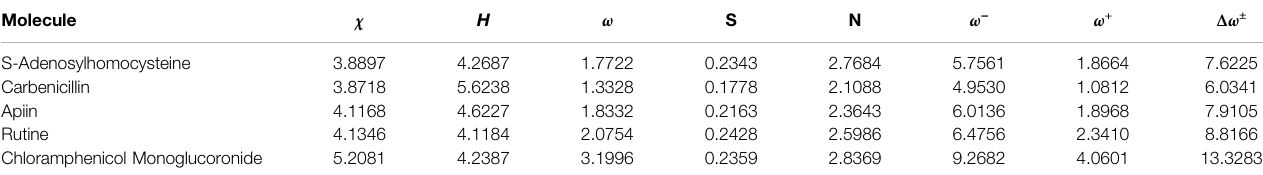
TABLE 4| GlobalReactivity DescriptorsoftheFive Studied Ligands: Electronegativity( χ ),Hardness ( η ),Electrophilicity ( ω ) (allineV), Softness (S)(in eV − 1 ),Nucleophilicity (N), Electrodonating Power ( ω − ), Electroaccepting Power ( ω + ) and Net Electrophilicity ( Δ ω ± ) (also in eV). Molecule